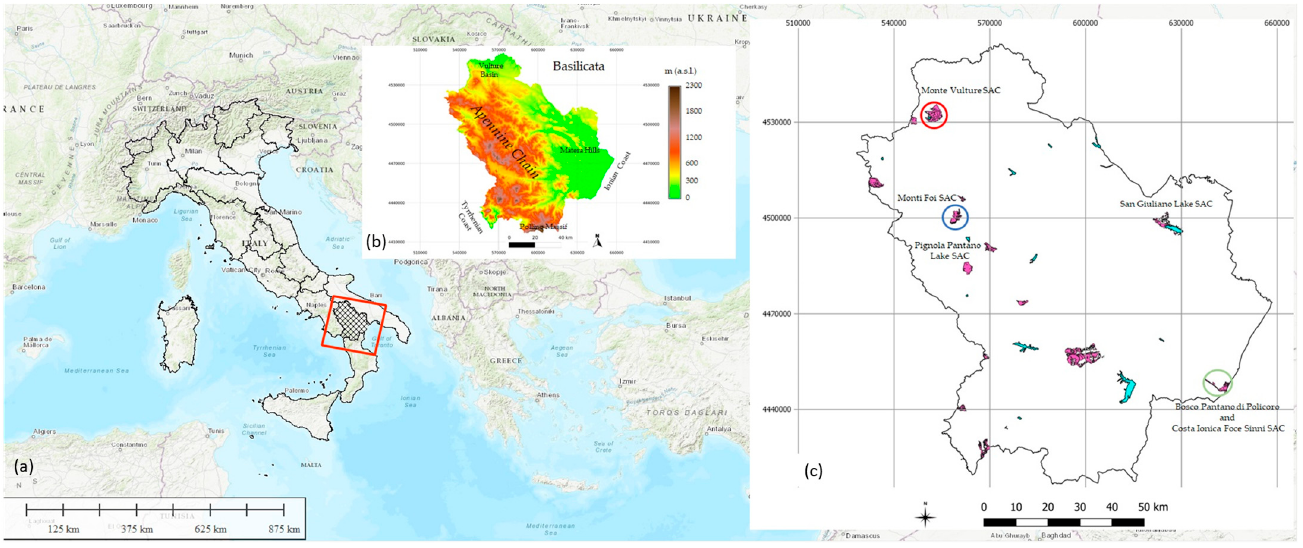
Figure 1. ( a ) Location of Basilicata with the 20 administrative units (NUTS2—Nomenclature of territorial units for statistics) of Italy and in red the footprint of Landsat path 188 and row 032; ( b ) DEM (Digital Elevation Model) of the study area with the main natural toponyms; ( c ) investigated SACs of Natura 2000 network of the Basilicata. Sites discussed in depth as case studies are circled, whereas in cyan, the main inner water bodies are reported.